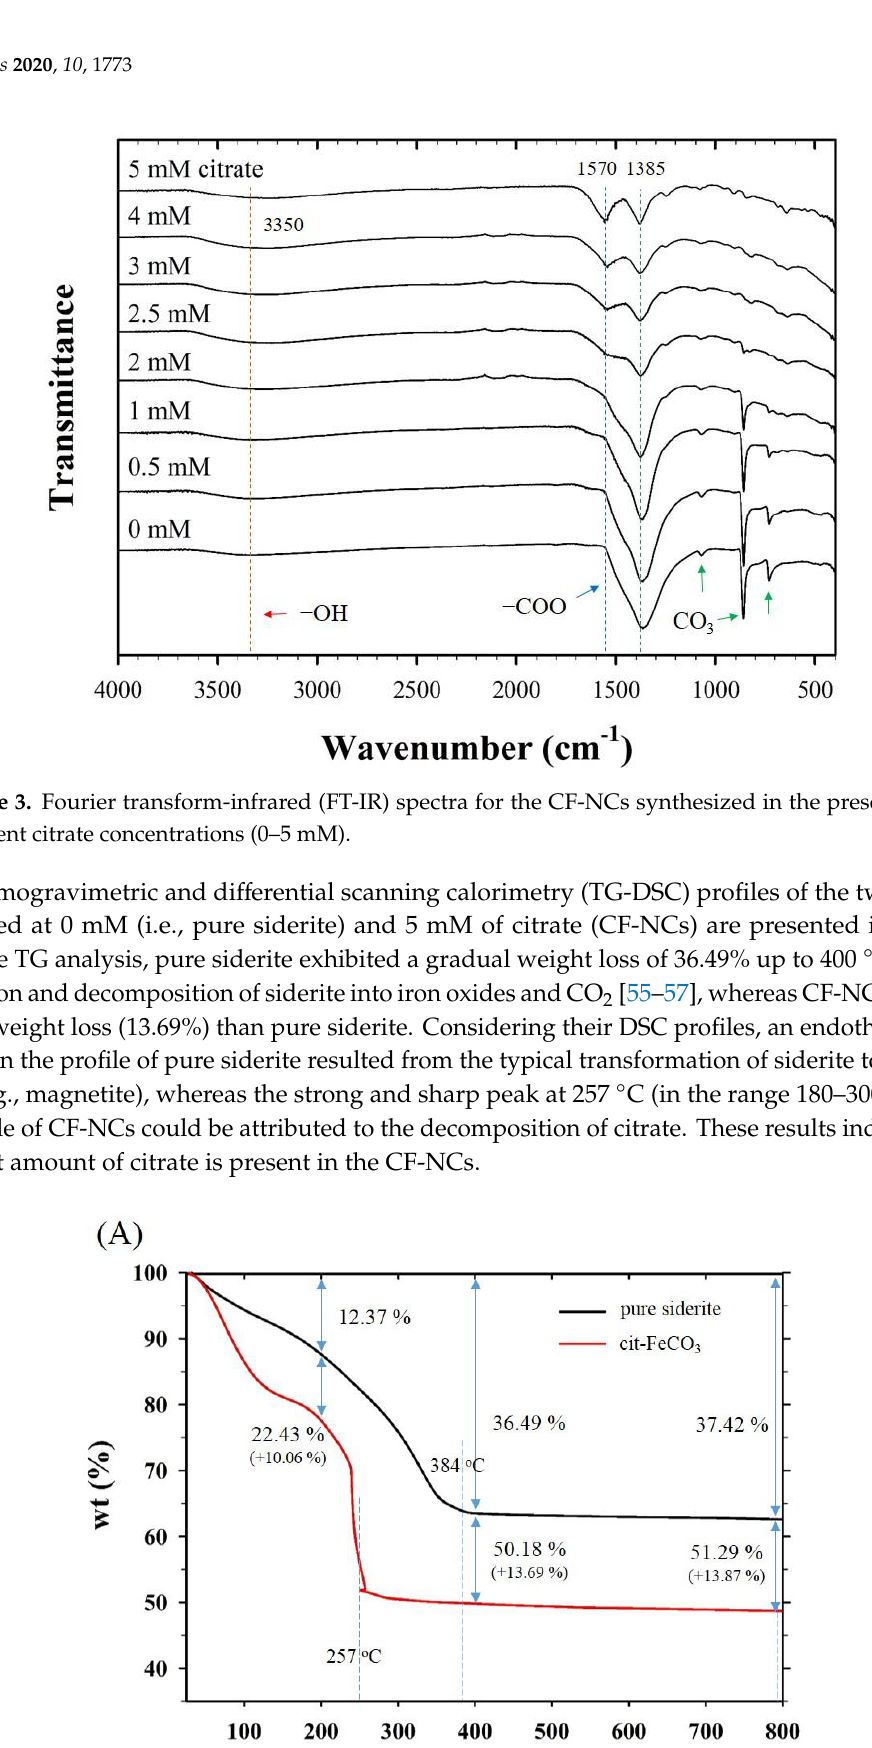
Figure 4. ( A ) Thermogravimetric (TG) and ( B ) differential scanning calorimetry (DSC) profiles of the two CF-NCs synthesized at 0 mM and 5 mM citrate concentration, respectively. Table 1. Chemical composition of the CF-NC samples synthesized in the presence of different citric acid concentrations (0–5 mM). a [Citrate] ini in Solution (mM)